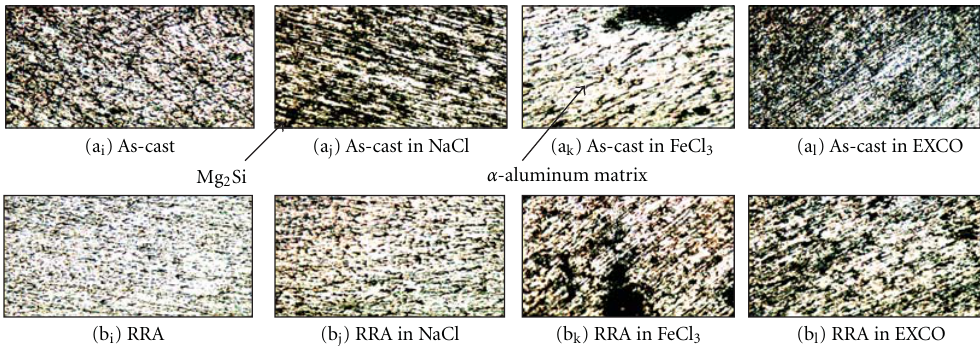
Figure 8: Micrographs of 1.23% Mg addition for untreated (a i –a l ) and treated (b i –b l ) specimens.